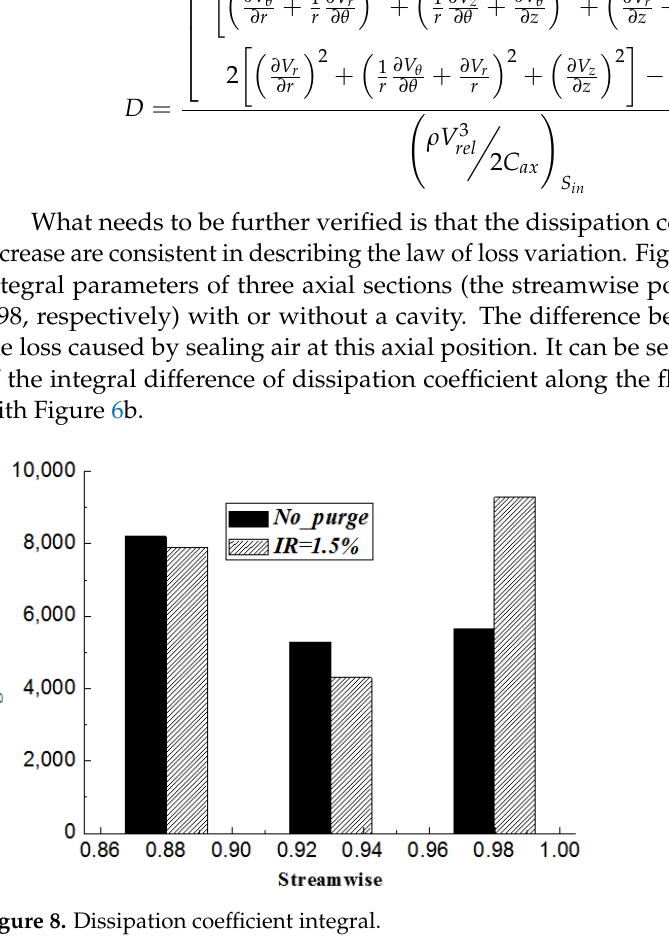
( b ) Blade surface Figure 9. Time-averaged pressure coefficient distribution.